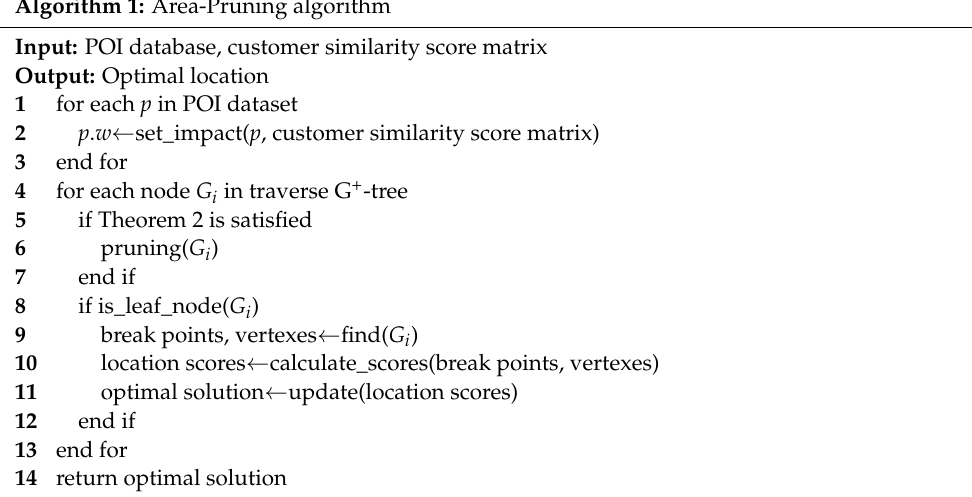
Algorithm 1: Area-Pruning